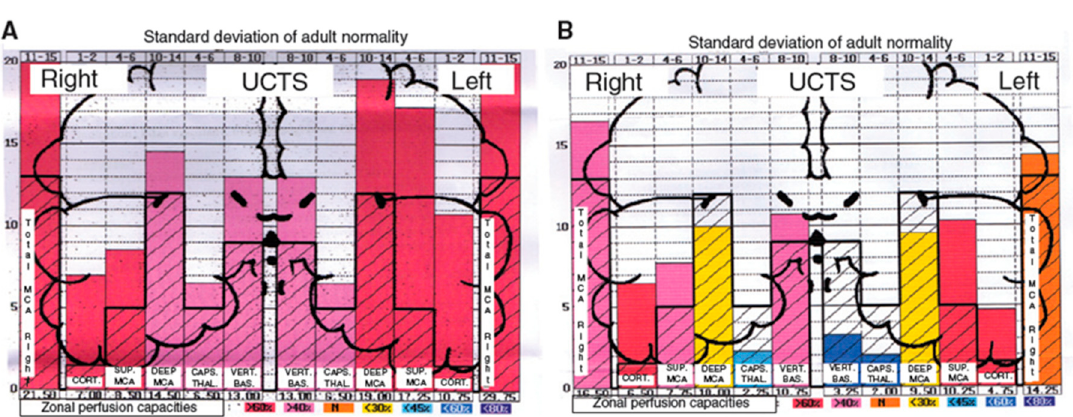
Figure 6. A case and a control using UCTS to explore the global centimetric ultrasound pulsatility in the two temporal lobes of: a normal subject ( A ); and an EHS self-reporting patient ( B ) [3]. Measurements are expressed in Pulsometric Index (PI). Note that in Figure 6A,B mean values of PI in each explored area recorded are from the cortex to the internal part of each temporal lobe; thus, on the left part of the two diagrams Figure 6A,B for the right lobe, mean PI values are expressed from the left to the right, while, on the right part of these diagrams for the left lobe, mean PI values are expressed from the right to the left. Note that in Figure 6A (normal subject) all values are over the normal mean values, whereas in Figure 6B (EHS-self reporting patients) values in the so-called capsulothalamic areas (the fifth and second columns for the right and left temporal lobe, respectively) are under the normal mean values. Table 3. Mean pulsometric index measurement ( ± SD) obtained by using UCTS in the di ff erent tissue areas investigated in temporal lobes of EHS-, MCS-, and EHS / MCS-bearing patients relative to normal concomitant controls (unpublished data).